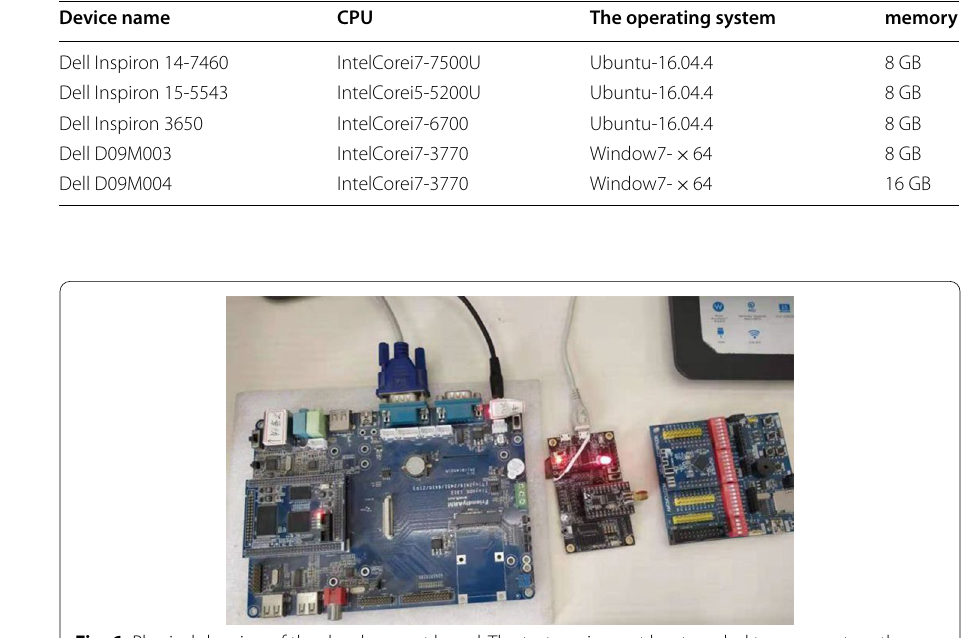
Fig. 6 Physical drawing of the development board. The test equipment has two desktop computers, three laptops, one IoT gateway development board, and two Wi-Fi development boards. The laptop, as the access host device, initiates the resource applies to the object while maintaining the private blockchain